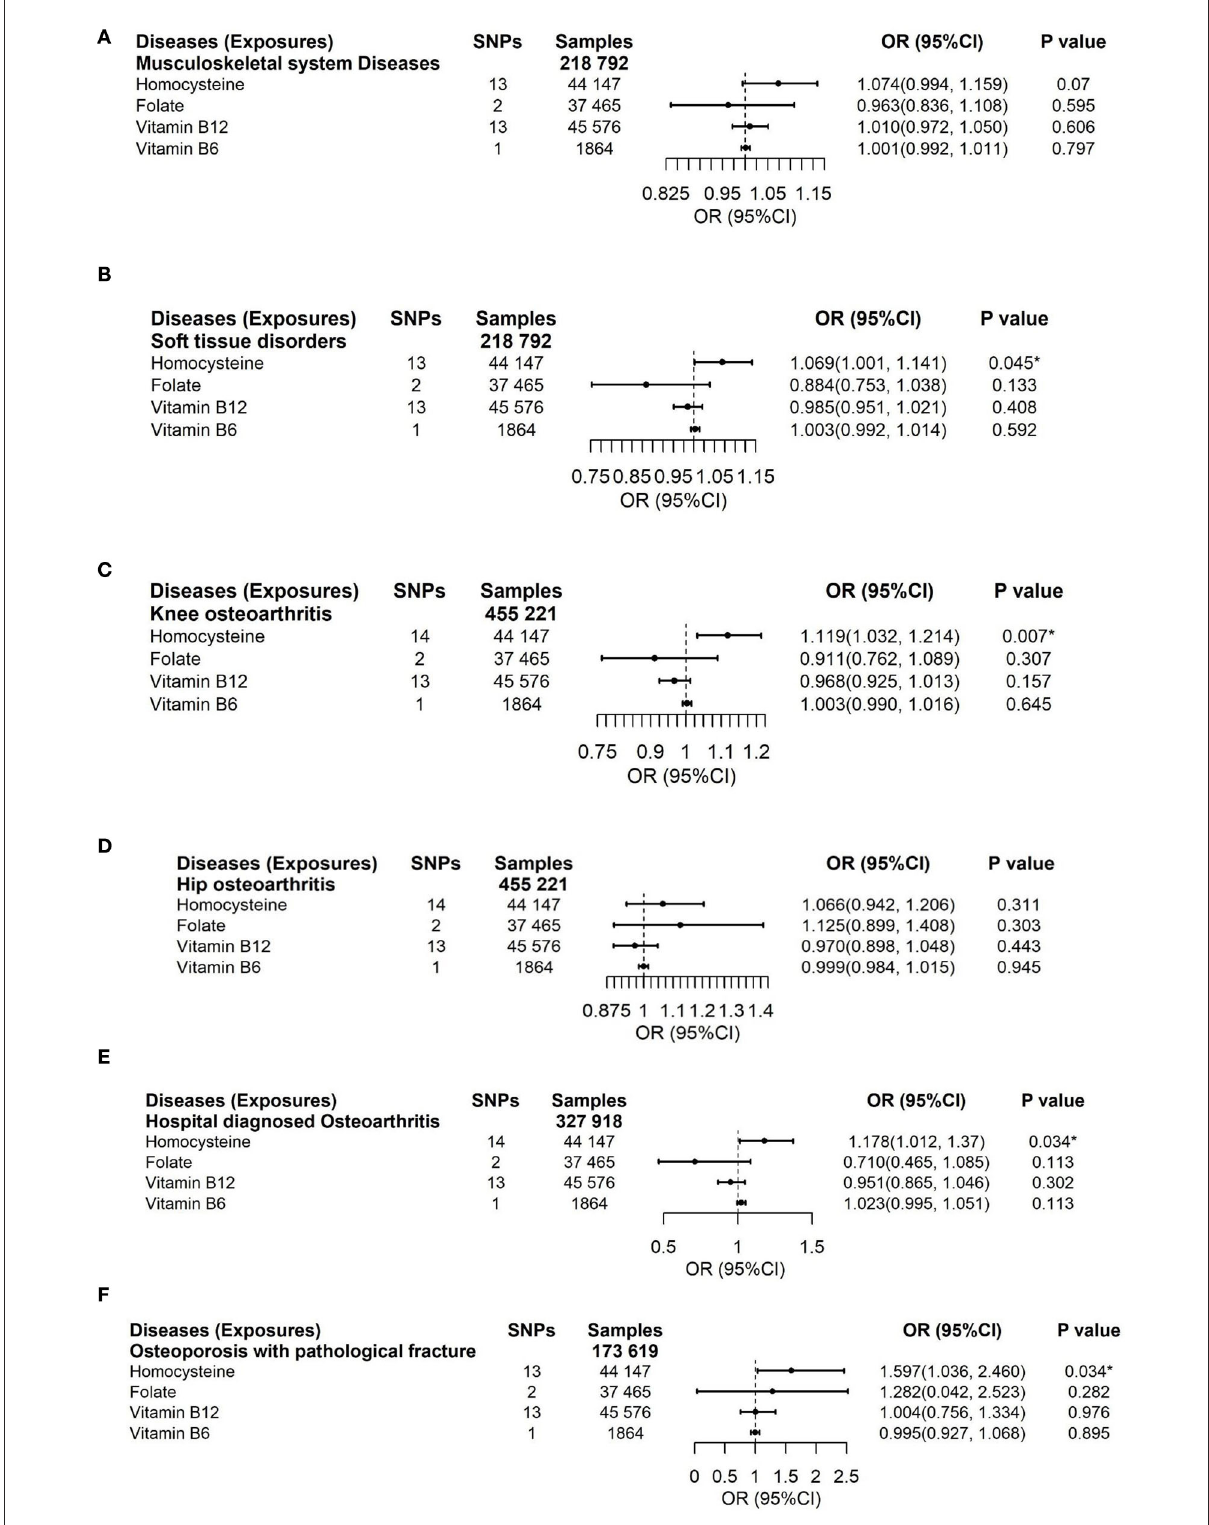
FIGURE3 Effects of genetically predicted circulating homocysteine, vitamin B6, folate, and vitamin B12 on musculoskeletal system diseases (A) , soft tissue disorders (B) , knee osteoarthritis (C) , hip osteoarthritis (D) , hospital-diagnosed osteoarthritis (E) , and osteoporosis with pathological fracture (F) via IVW method. CI, confidence interval. The summary statistics data of UKB can be downloaded from Nealelab (http://www.nealelab.is/uk- biobank). The summary statistics data in FinnGen Consortium can be downloaded from Google cloud storage free of charge (https://www. finngen.fi/en/access_results). * P value reached the significant level; SNP, single nucleotide